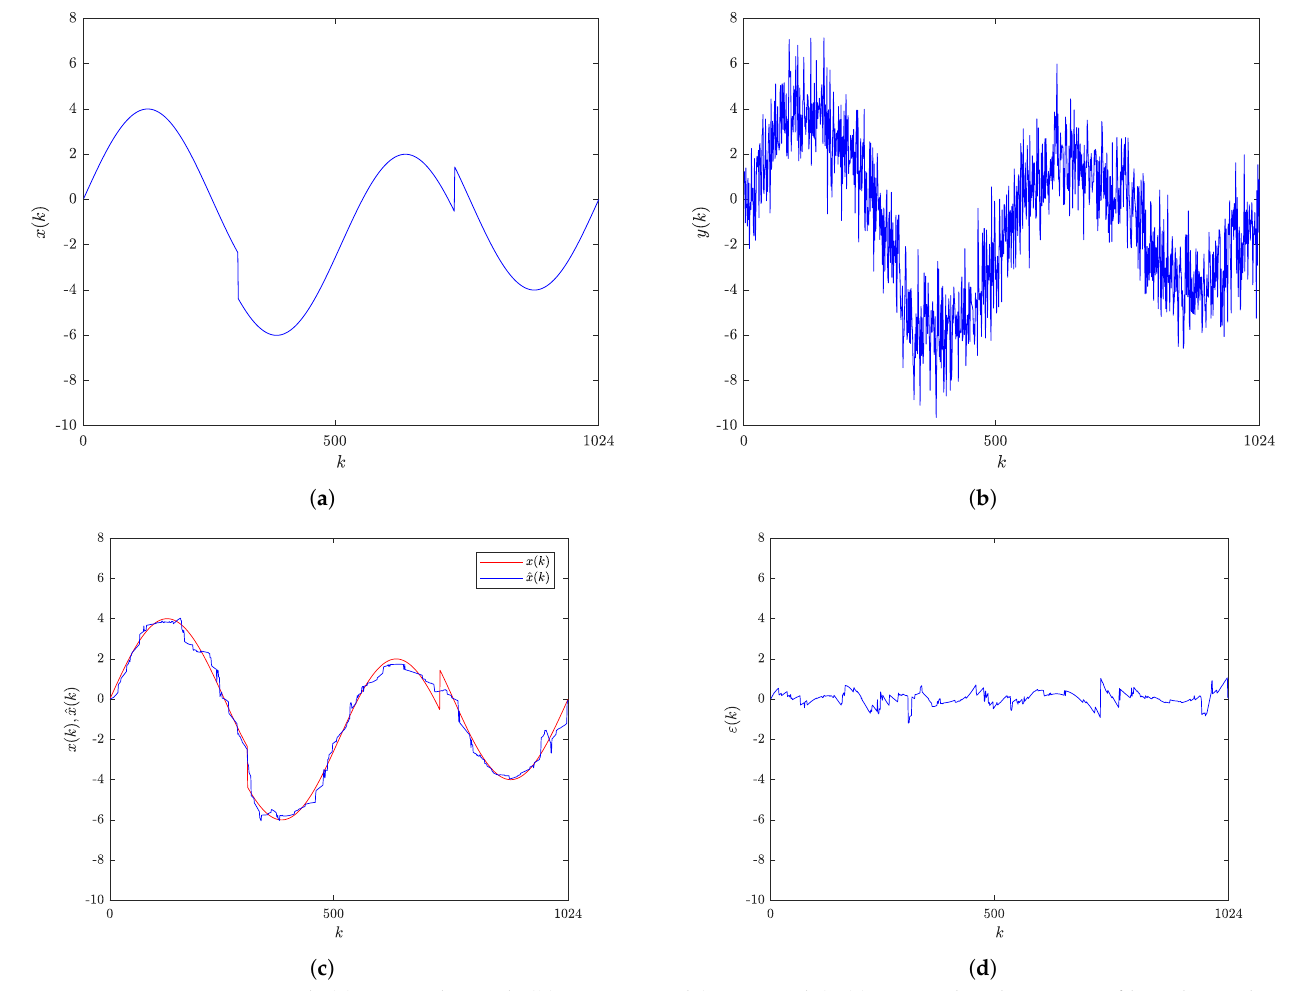
Figure 4. HeaviSine signal: ( a ) Original signal. ( b ) Noisy signal (SNR = 7 dB). ( c ) Original and RBF-RICI filtered signal ( Γ = 4.98, R c = 0.99). ( d ) Filtering